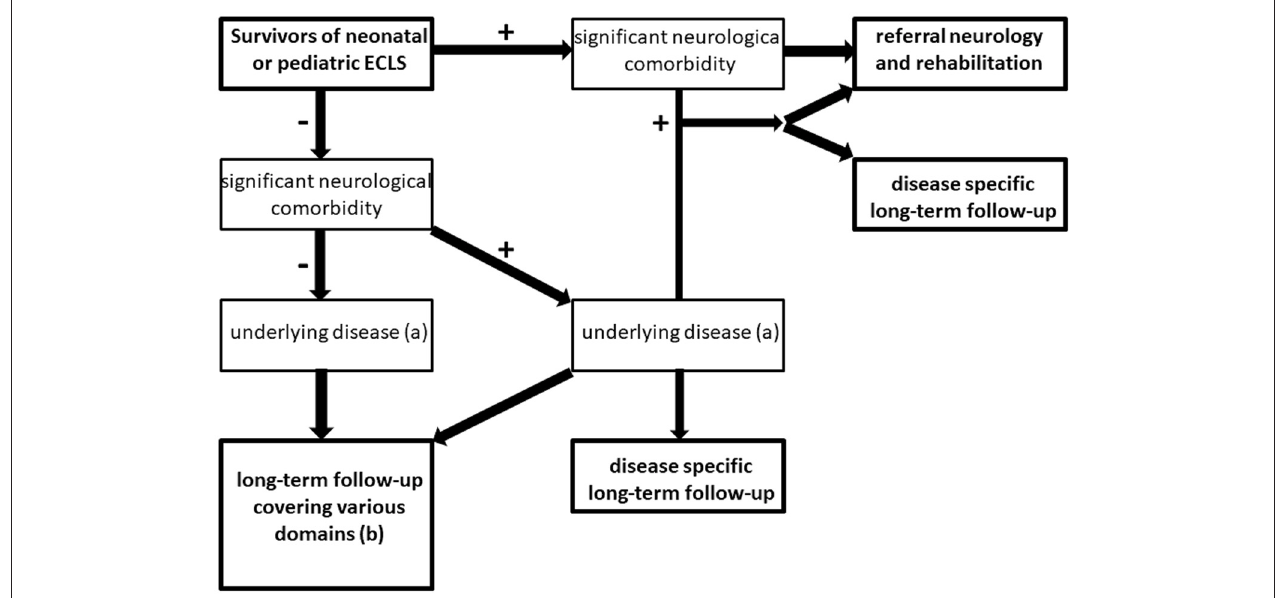
FIGURE 3 | Flowchart for long-term follow-up of ECMO survivors. + : indicates condition present; – indicates condition absent, (a) e.g., cardiovascular disease, pulmonary disease, genetic syndrome, psychiatric disease (including delirium, post-traumatic stress disorder or anxiety disorder following critical illness) (b) see Table 1 for domains that should be covered in follow-up of ECMO survivors without (serious) neurologic comorbidity.